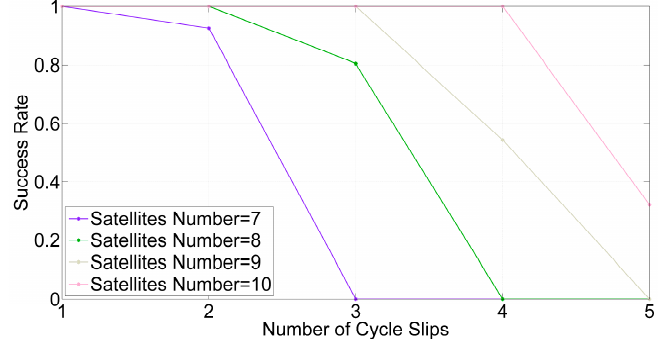
Figure 8. Success rates of detecting cycle slips by different numbers of satellites and cycle slips with GPS.